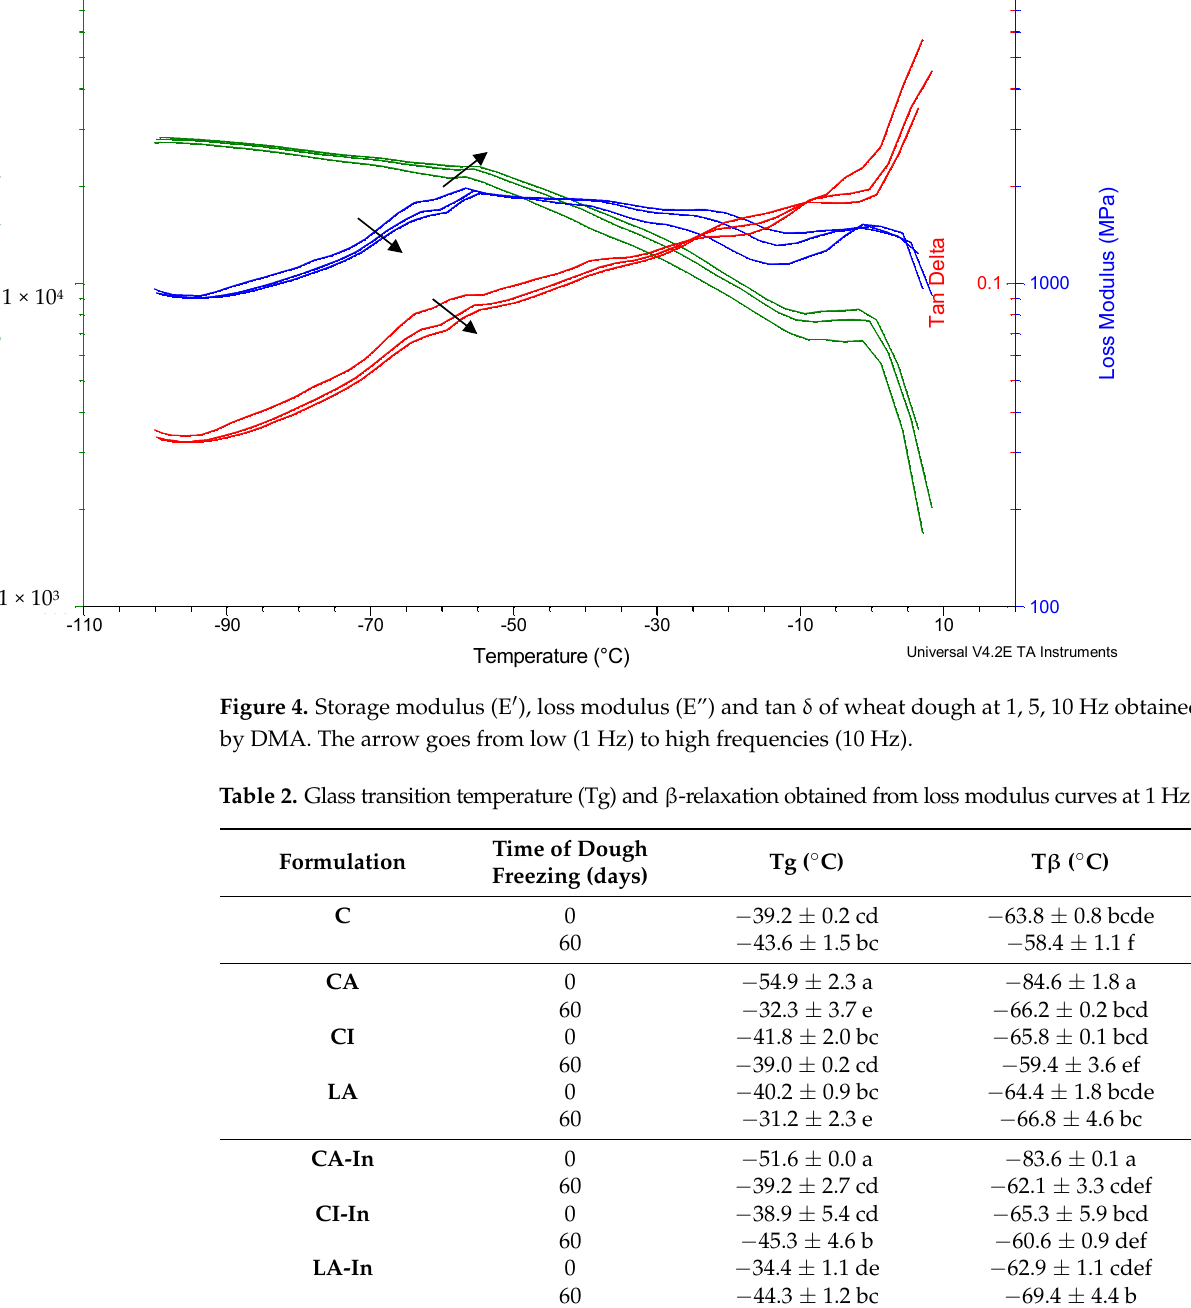
Table 2. Glass transition temperature (Tg) and β -relaxation obtained from loss modulus curves at 1 Hz.